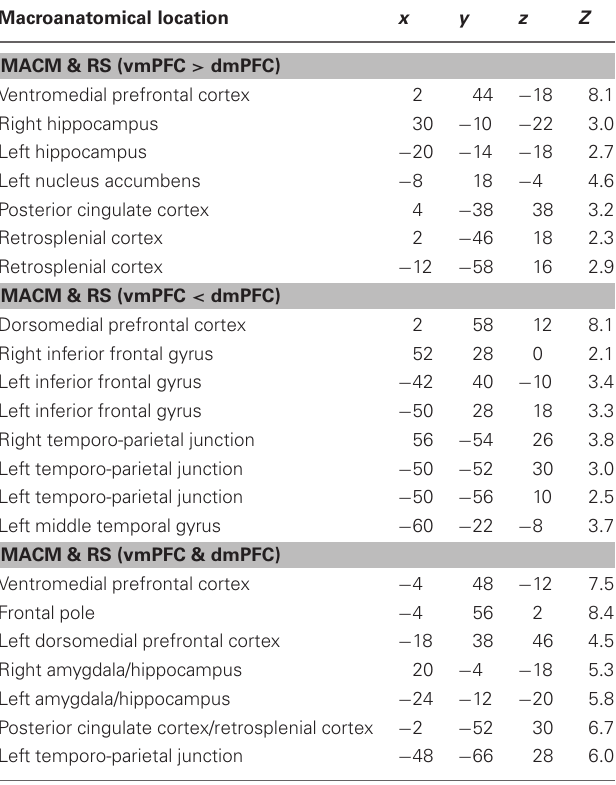
Table 3 | Difference and conjunction analyses between functional connectivity of the vmPFC and dmPFC